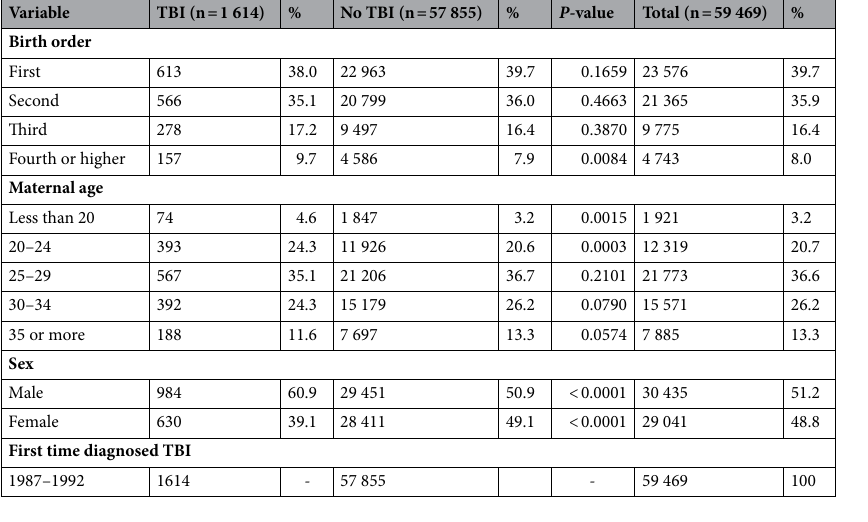
Table 1. Characteristics of the first time diagnosed TBI in Finland 1987–2005 in Finnish Birth Cohort with a follow-up of 18